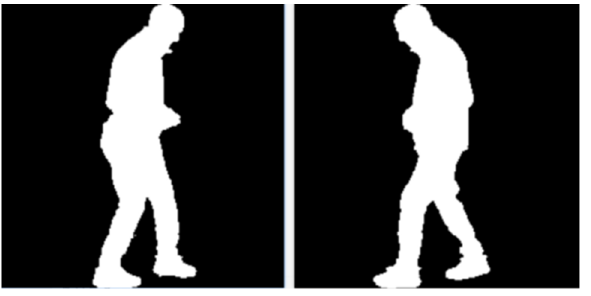
Figure 5. Examples of walking forward ( right ) and walking backward ( left ) of a gait contour map. Table 1. The specific content of GAIT ‐ IST and GAIT ‐ IT datasets for PD patients and other controls.